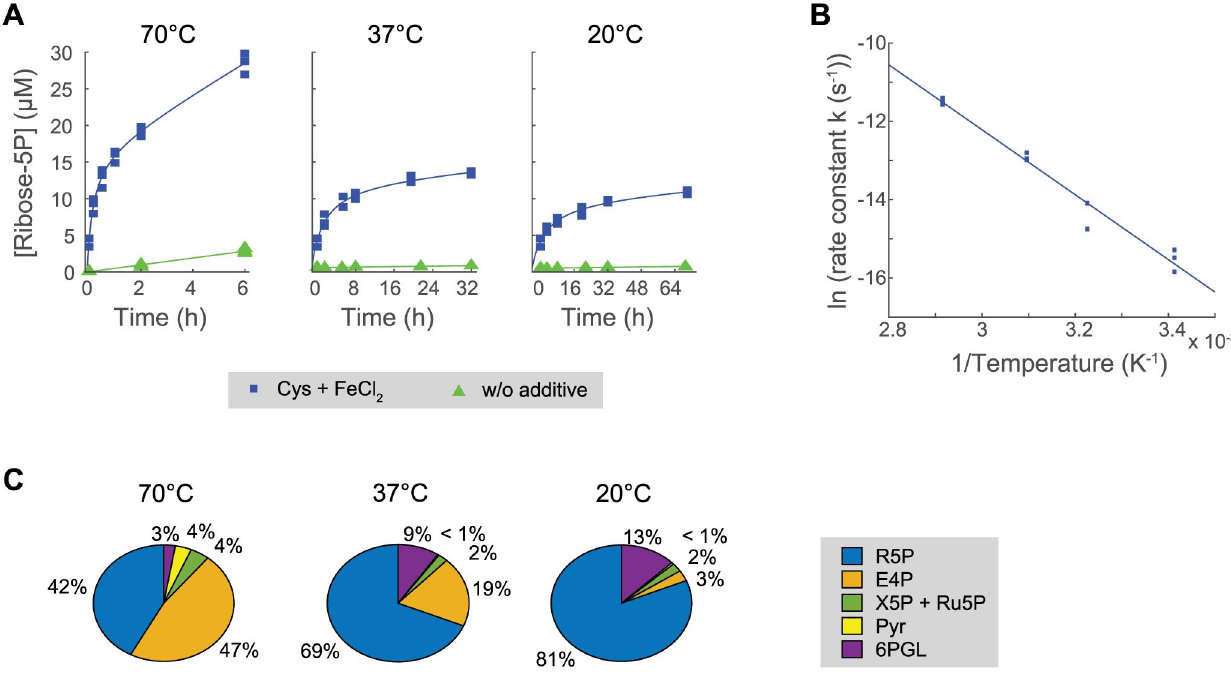
Fig 4. Specific metabolism-like nonenzymatic R5P formation at different temperatures. (A) R5P concentration over time, formed upon the incubation of 800 μ M 6PG in 50 mM phosphate solution pH 5 at different temperatures in the presence of 75 μ M cysteine and 75 μ M FeCl 2 . Notice that time ranges were adapted according to the temperature scaling kinetics. Experimental data (points; N = 3) conform to hyperbolic fits (lines). Trends without the additives are shown for comparison (see S1 Data). (B) Initial rate constants calculated from (A) scale exponentially with the absolute temperature, following Arrhenius’ equation. The linear slope in the plot of log-transformed values gives a value for the activation energy E a of 69 kJ mol − 1 (see S1 Data). (C) Long- term product specificity at different temperatures. Relative concentrations of the different detected sugar phosphate products are shown for the last recorded time point per temperature condition from the experiments in (A) (average from N = 3 experiments) (see S1 Data). R5P, ribose-5-phosphate.